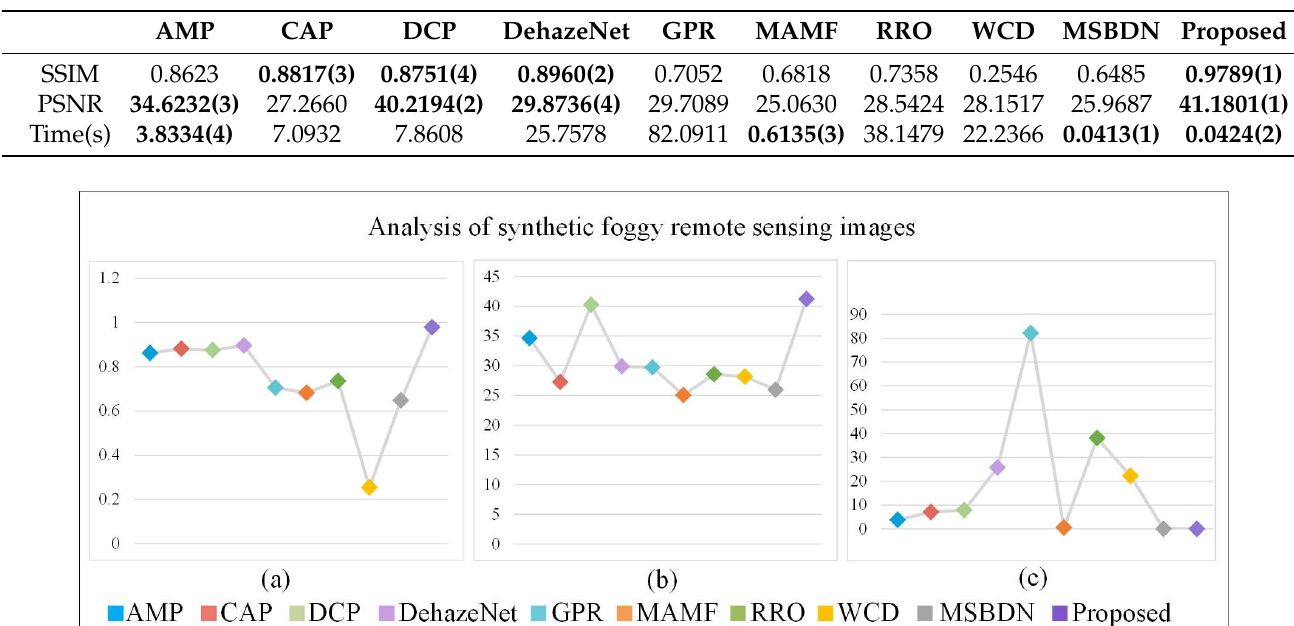
Table 2. Analysis of the defogging performance of the synthetic foggy remote sensing images using three evaluation indicators. The top four results are marked in bold, and the corresponding rankings are shown in parentheses. The higher SSIM and PSNR values are better.